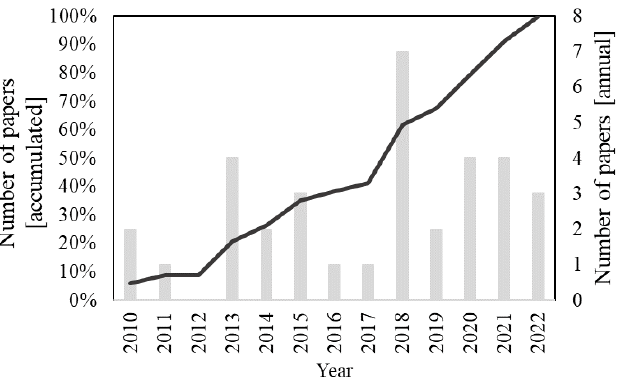
Figure 2. Distribution of the 34 papers from the final sample (after title, abstract, and full-text screening) related to the search string “photocatal* and ((“titanium dioxide”) or TiO 2 ) and coat* and (“mortar” or “facade” or “façade”)” over time.